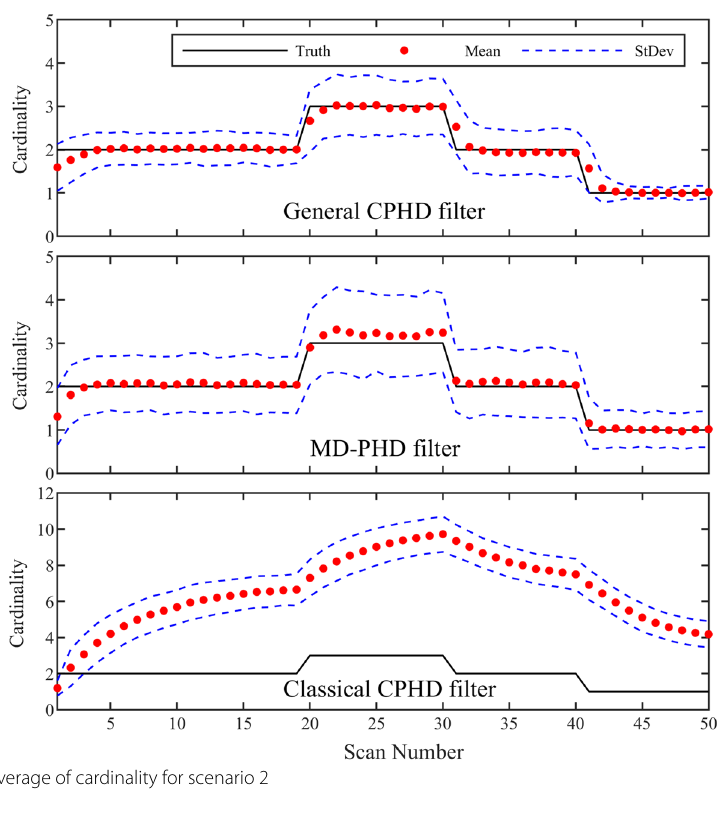
Fig. 8 Average of cardinality for scenario 2